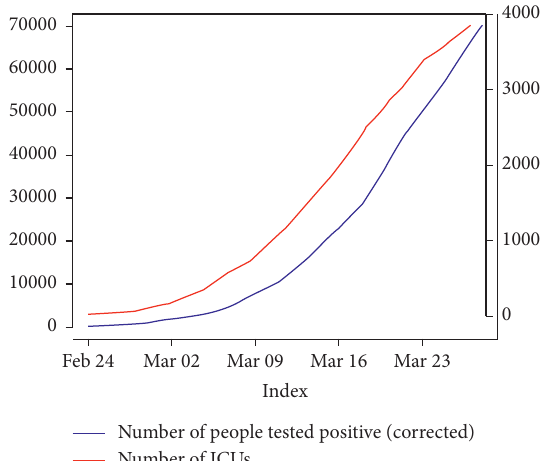
Figure 4: Italy, time series data of positive (data corrected via Kalman filter, left side axis) and of the number of people hospi- talized in ICUs (right side